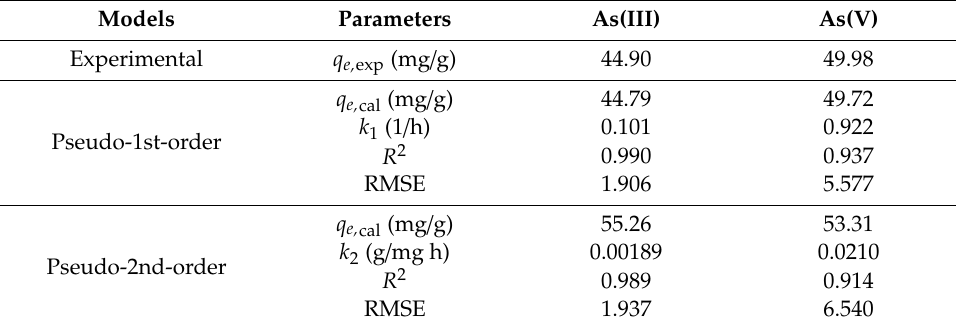
Table 2. Sorption kinetics parameters for As(III) and As(V) using CF-NCs as sorbents.